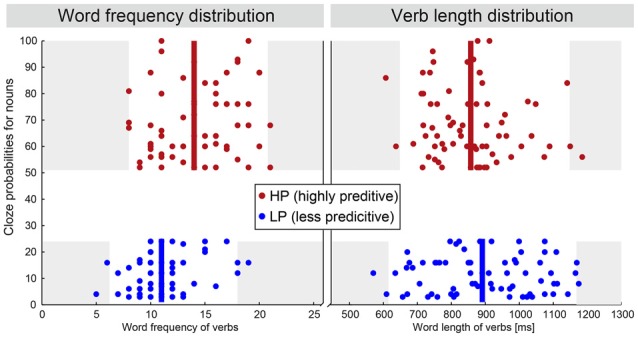
Distribution of the word frequency and word length values for the verbs in both conditions. Both differences are small and therefore considered irrelevant for the effects discussed here. For more details see “Materials and Methods” Section—Stimuli. The white area marks the centered 95% percentile.